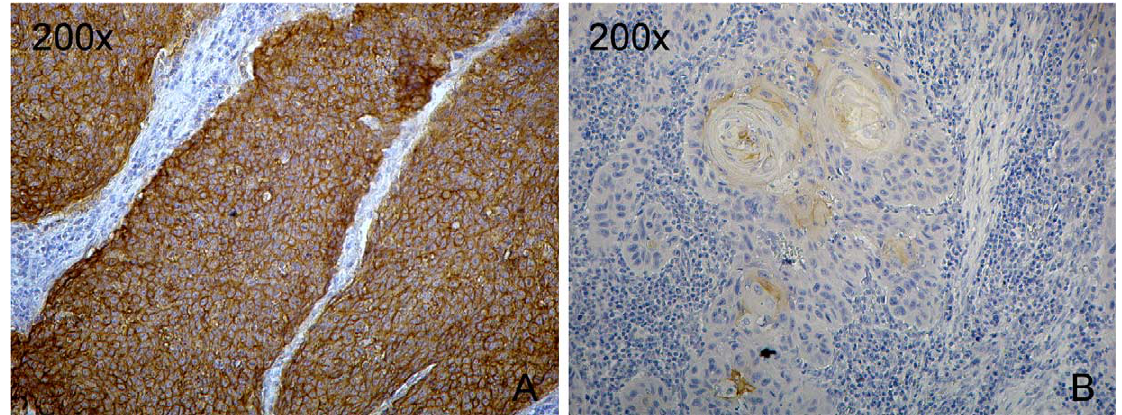
Fig. 2. E48 immunostaining. Representative example of E48 immune peroxidase staining of a tumor with high (100%) hLy-6D expression (A) or low (5%) hLy-6D expression